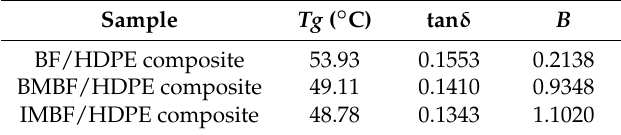
Table 5. The dynamic mechanical data and B value of composites.